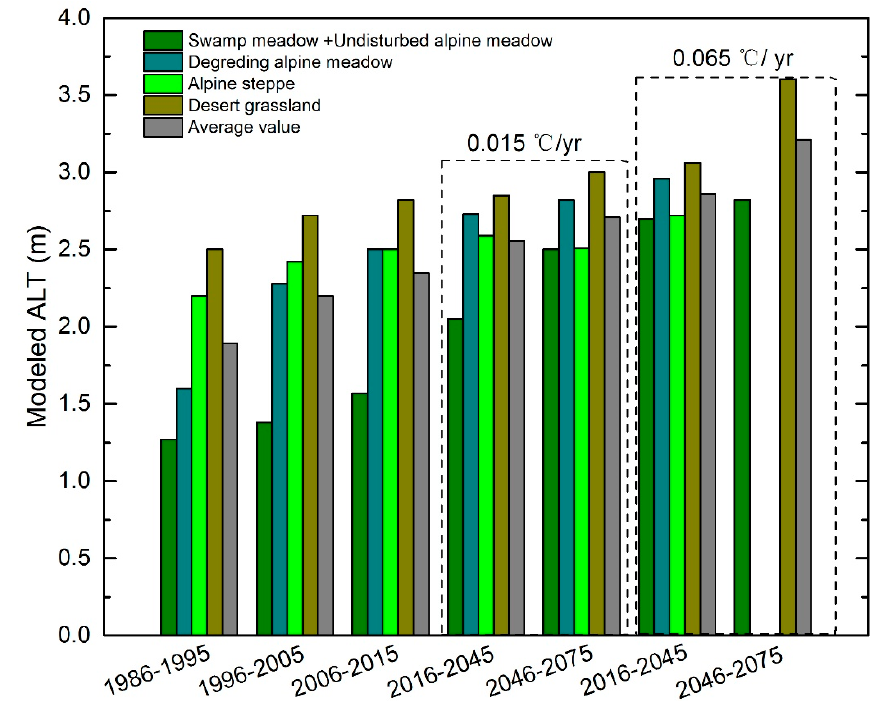
Figure 10. Distributions of modeled ALTs for different ecosystem units in 1986–1995, 1996–2005, 2006–2015, 2016–2045, and 2046–2075.